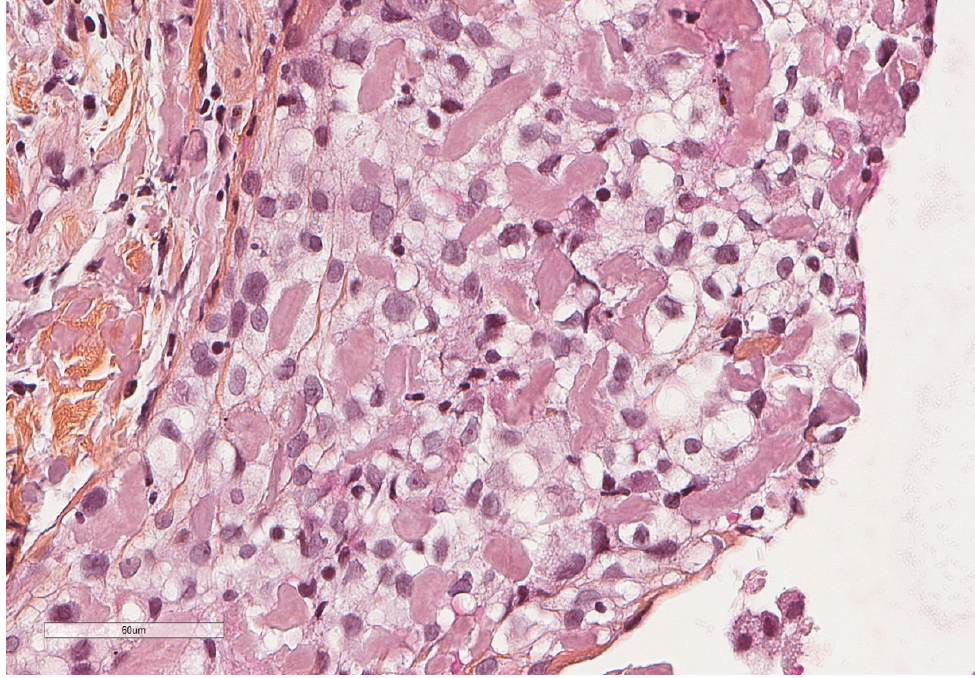
Figure 7. At higher magnification, an amorphous, eosinophilic, extracellular material is seen, corre- sponding to amyloid deposits. Hematoxylin, eosin, saffron staining (×400). The yellow nail syndrome, a likely acquired condition of unknown pathophysiology is characterized by yellow slow-growing nails, lymphedema and chronic respiratory man- ifestations, such as pleural effusion, bronchiectasis, chronic sinusitis, and recurrent pneu-